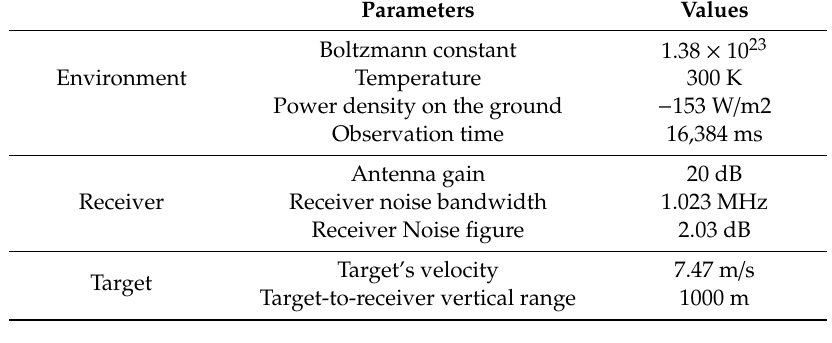
Table 5. Simulation parameters for chirp rate estimation.